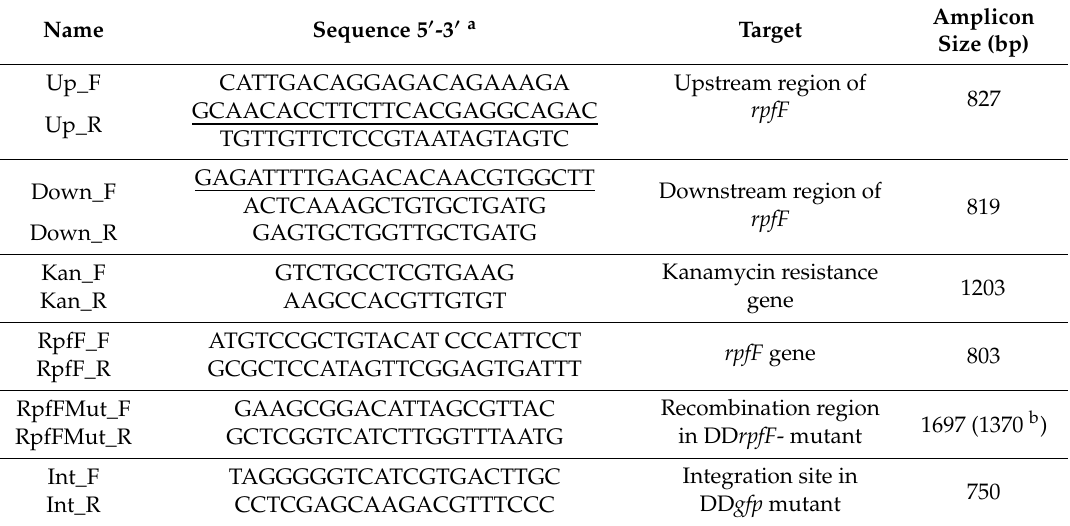
Table 1. Primers used in this